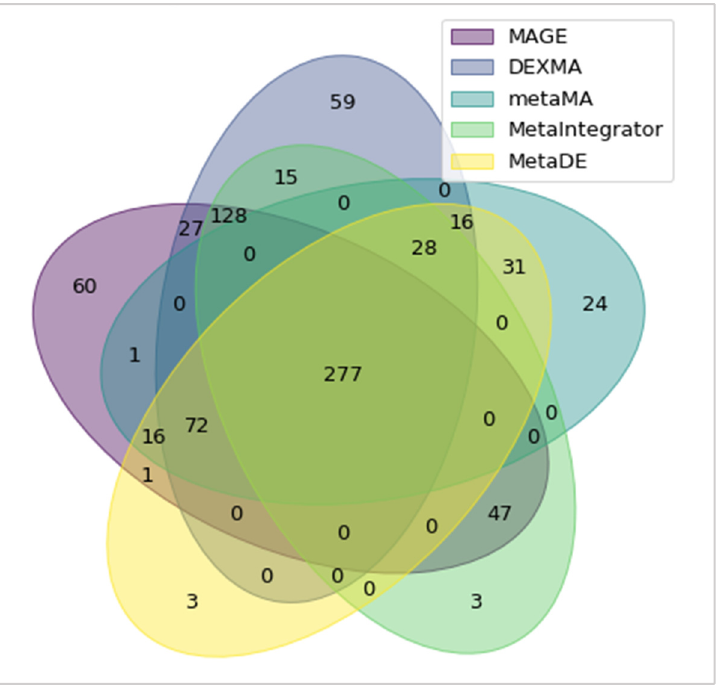
Figure 5. Venn diagram for the common genes that were identified as differentially expressed in each meta-analysis